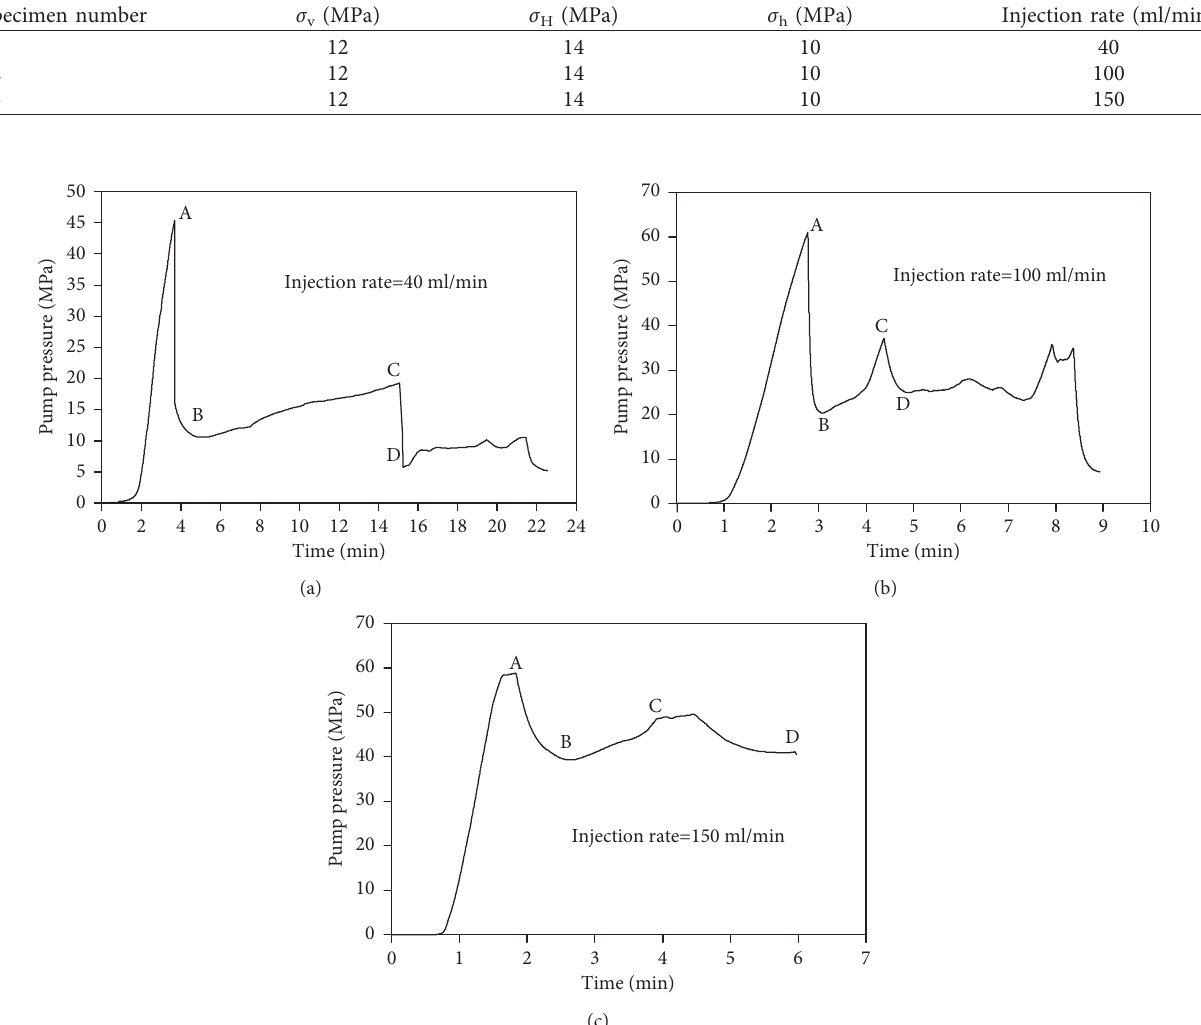
Figure 4: Pumping pressure-time curve for hydraulic fracturing experiments: (a) S1; (b) S2; (c)